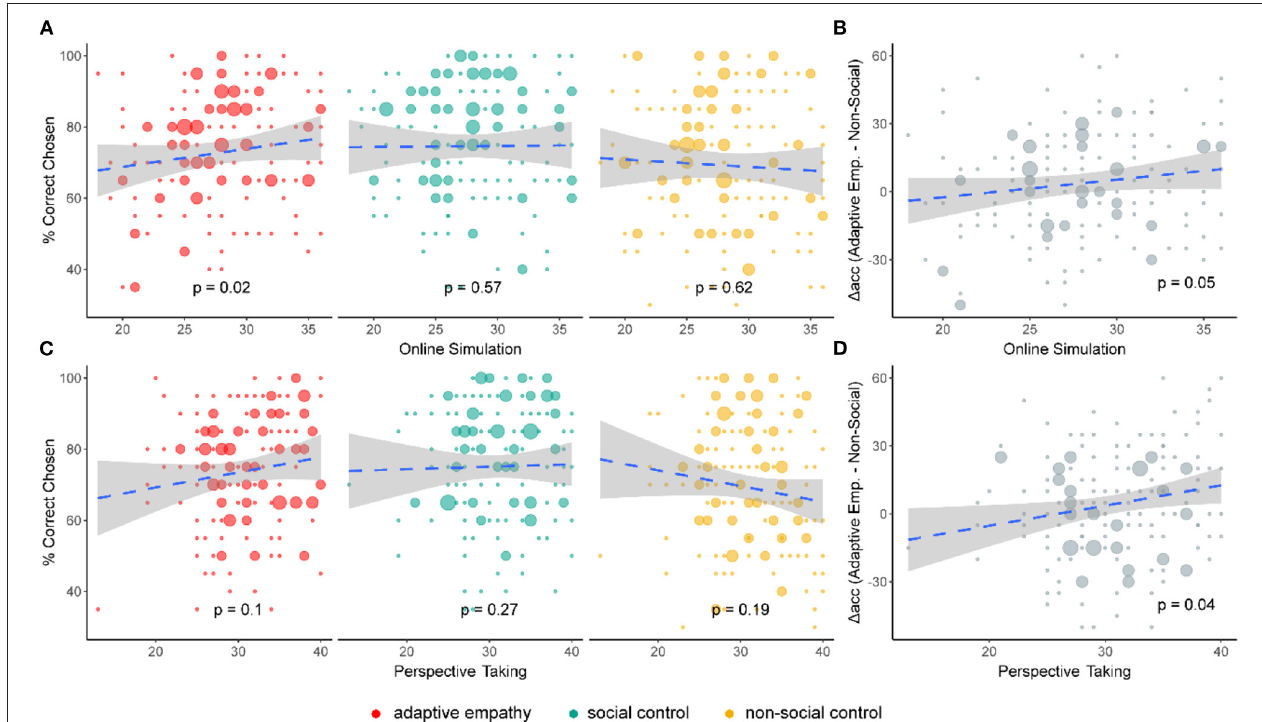
FIGURE 3 | Cognitive empathy subscales. (A) Correlations between task conditions and cognitive empathy trait: participants high on the online simulation subscale exhibited higher performance in adaptive empathy. There was no such correlation in other conditions. (B) Correlation of difference in accuracy between adaptive empathy and non-social control with cognitive empathy trait: participants high in online simulation had a larger gap in accuracy between the two conditions. (C) Same as (A) , but for the perspective taking subscale. No correlation was found with performance in any of the conditions. (D) Same as (B) , but for the perspective taking subscale: participants high in perspective taking had a larger gap in accuracy between the two conditions. Dashed lines indicate the fitted linear regression, gray areas indicate a 95% confidence